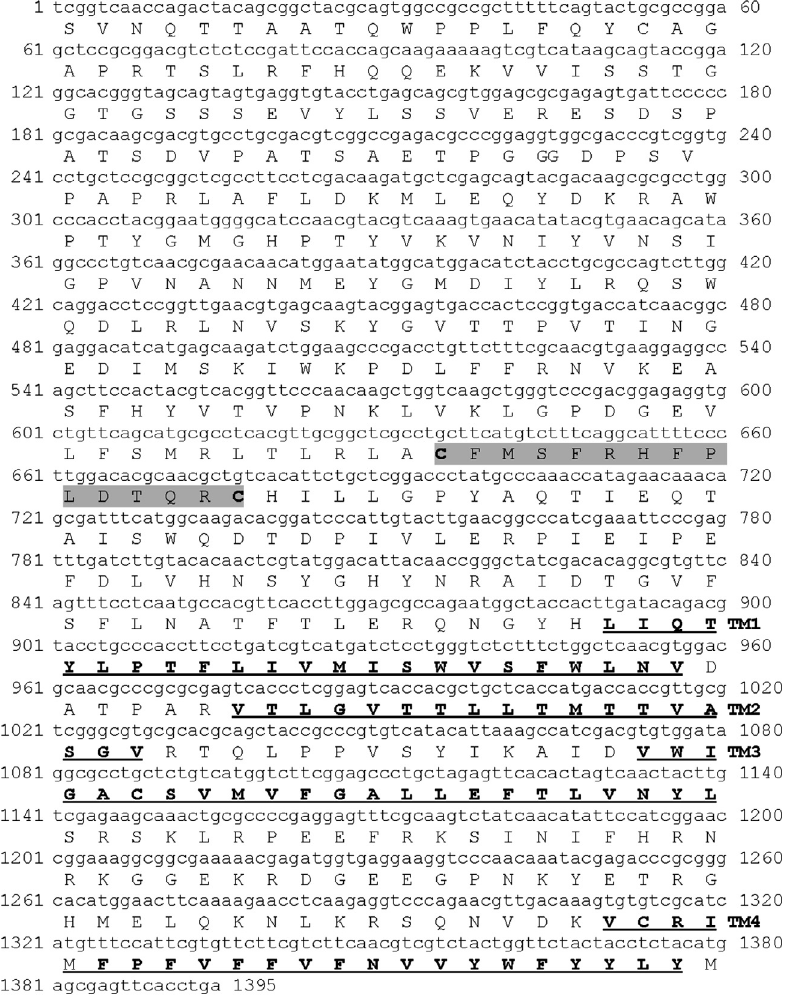
Figure 1. Nucleotide and deduced amino acid sequence of the putative GlyR channel from R. microplus . The cysteines forming the Cys-loop are highlighted in gray shading and the putative membrane domains (TM1–TM4) are underlined in bold. The hyphen indicates the stop codon.